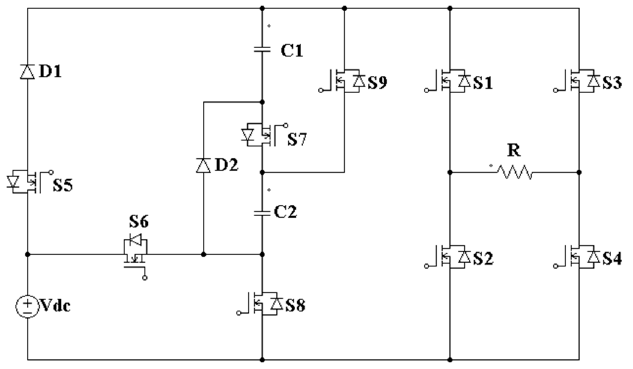
Figure 11. Circuit diagram for multilevel inverter.